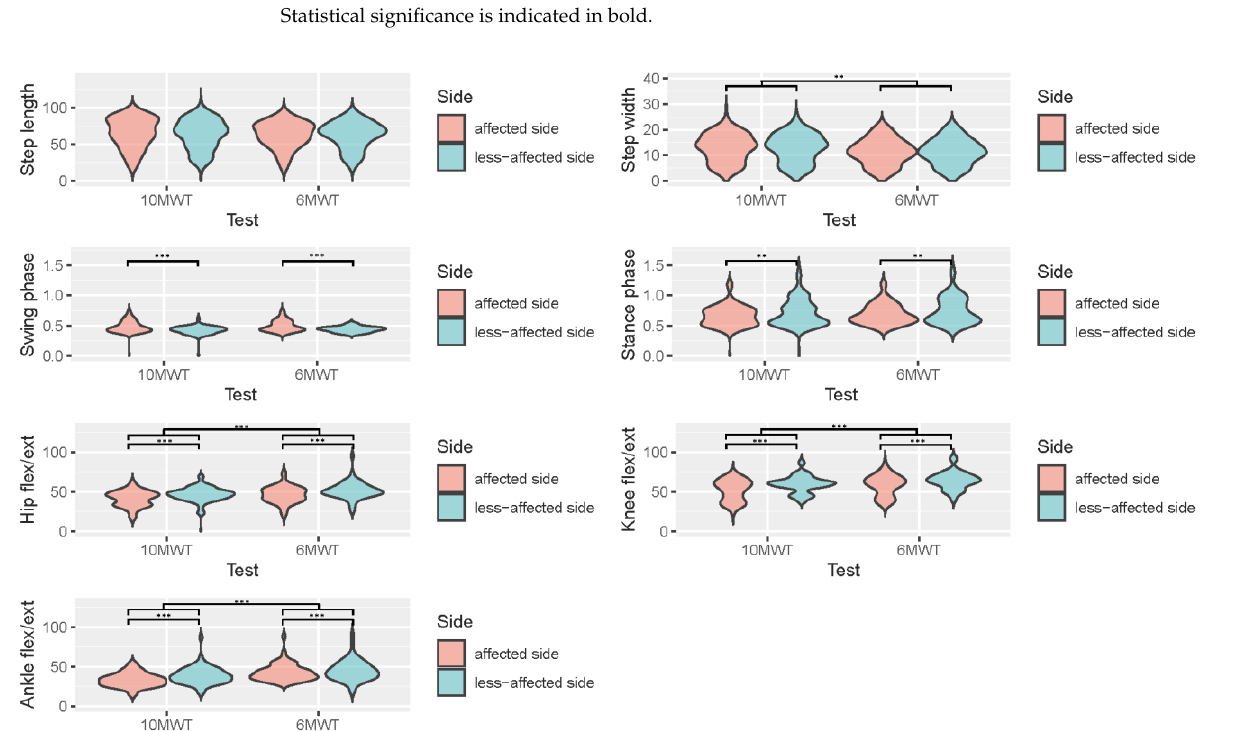
Table 3. Comparison of the affected vs. less-affected leg and 10MWT vs. 6MWT per gait metric